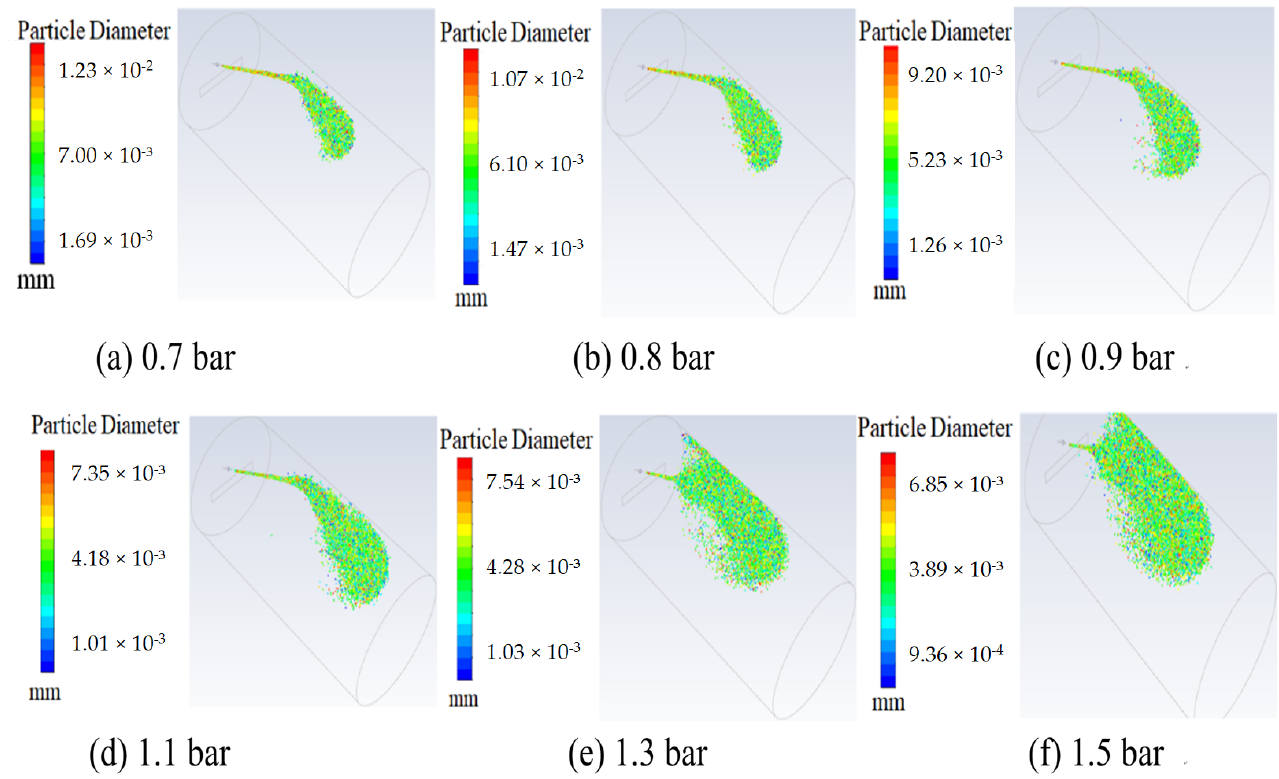
Figure 7. Contour images of atomization particles under different compressed air pressures.